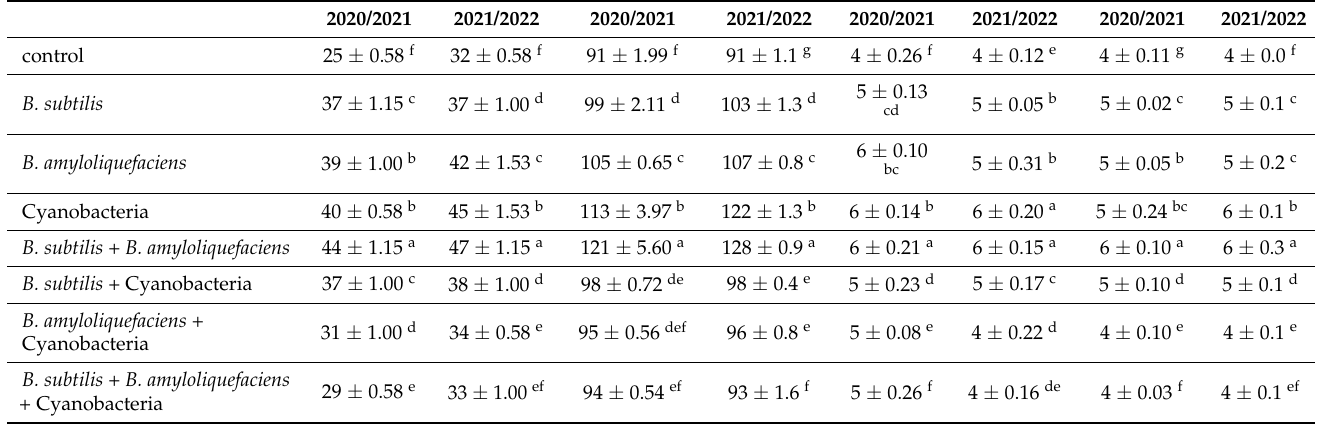
Table 2. The effect of inoculation with two PGPR strains ( B. subtilis and B. amyloliquefaciens ) and cyanobacteria on fruit features of tomato plants in two seasons (2020/2021) and (2021/2022). Different letters indicate significant differences between treatments (ANOVA, LSD, p < 0.05). Error bars represent standard error of the mean.